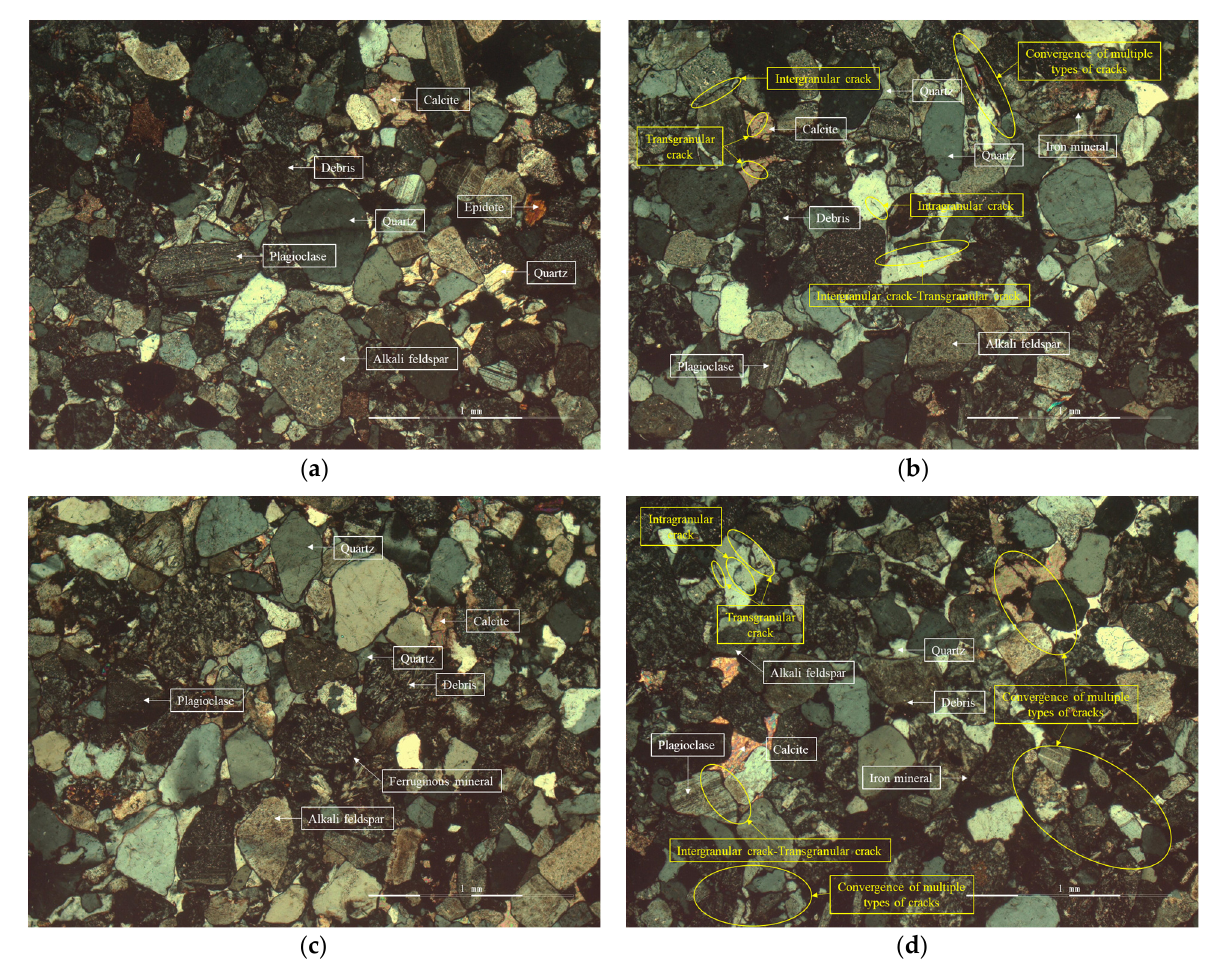
Figure 6. Orthogonal polarization image of sandstone samples: ( a ) natural water content sample before microwave radiation, ( b ) natural water content sample after microwave radiation, ( c ) sample soaked in water for 24 h before microwave radiation, and ( d ) sample soaked in water for 24 h after microwave radiation.